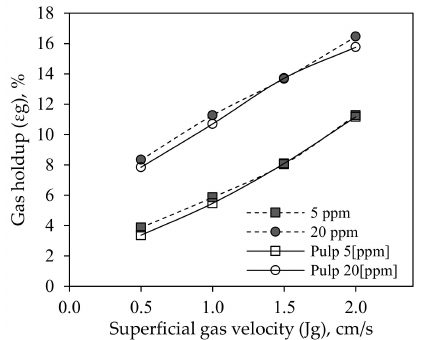
Figure 9. Gas holdup versus gas rate for a two and three-phase